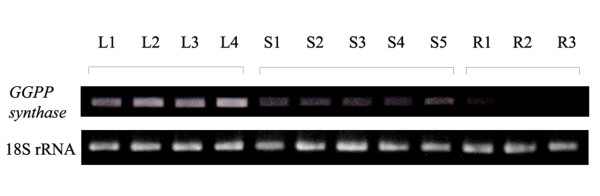
Expression of GGPP synthase in roots, stems and leaves of C. forskohlii culture. Ten microliters of PCR product was loaded in each lane. The lower panel shows 18S rRNA fragment as an internal control.